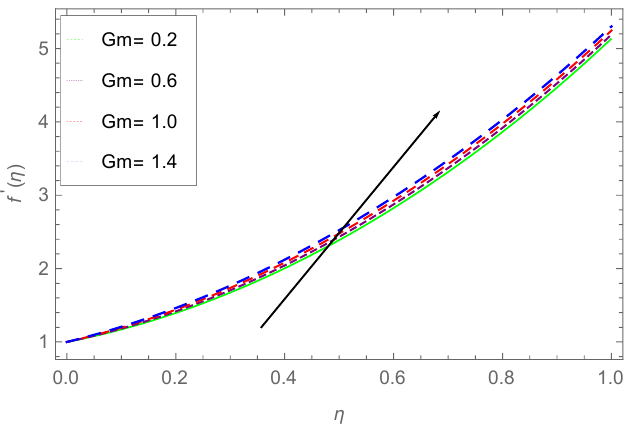
Figure 4. Impact of Gm on f (cid:48) ( η ) , when γ 1 = 0.2, β = 0.9, St = 0.3, Gr = 0.7, M = 0.9.